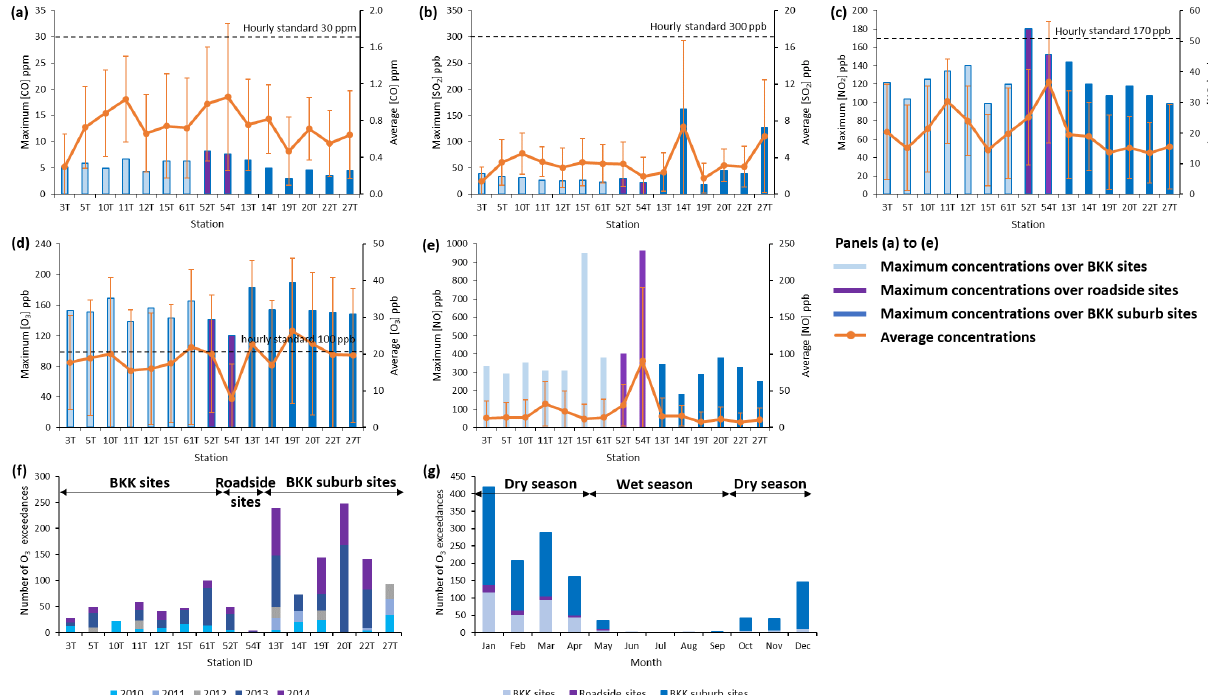
Figure 2. Maximum (vertical bars) and average (solid line) concentrations of (a) CO, (b) SO 2 , (c) NO 2 (d) O 3 and (e) NO from the 15 monitoring stations, from 2010 to 2014, are compared with the hourly NAAQs (dotted line) of Thailand (except NO, which is not a criteria pollutant). The number of hourly O 3 exceedances is shown by (f) locations and (g) seasons.